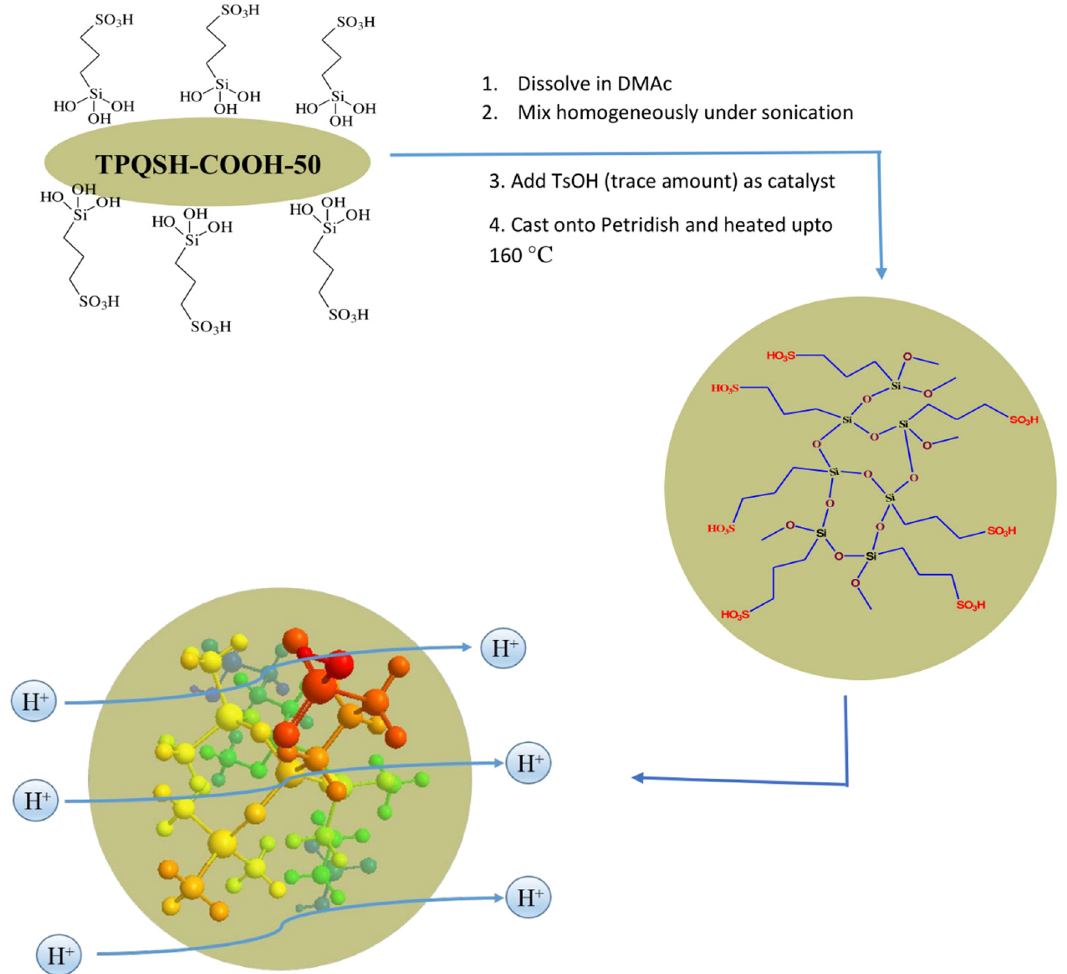
Figure 1: Architectural representation of the preparation of SPAES - SS - X composite membranes through the formation of an IPN structure.